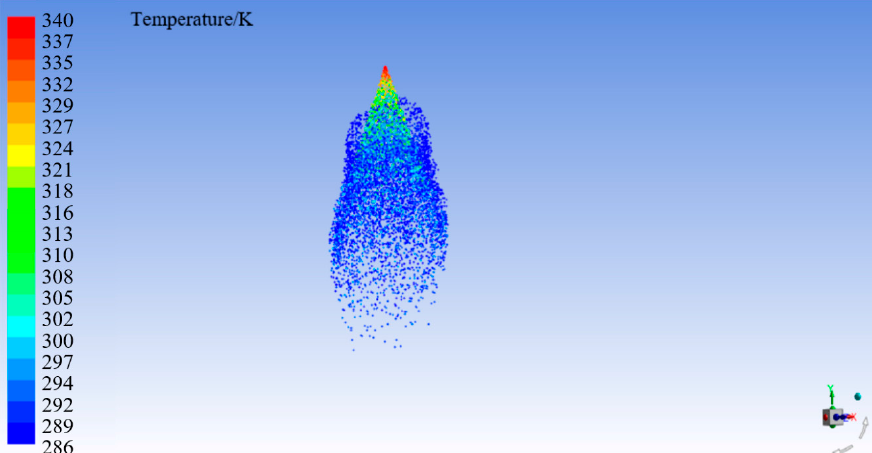
Figure 2. Temperature distribution model of atomizing nozzle.